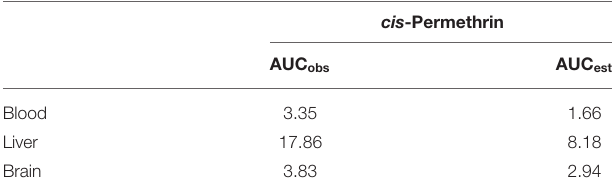
TABLE 6 | Area under the curve ( µ g h/ml or µ g h/g) of the observed concentrations (AUC obs ) and the estimated concentrations (AUC est ) for cis -permethrin in fetal blood, liver, and